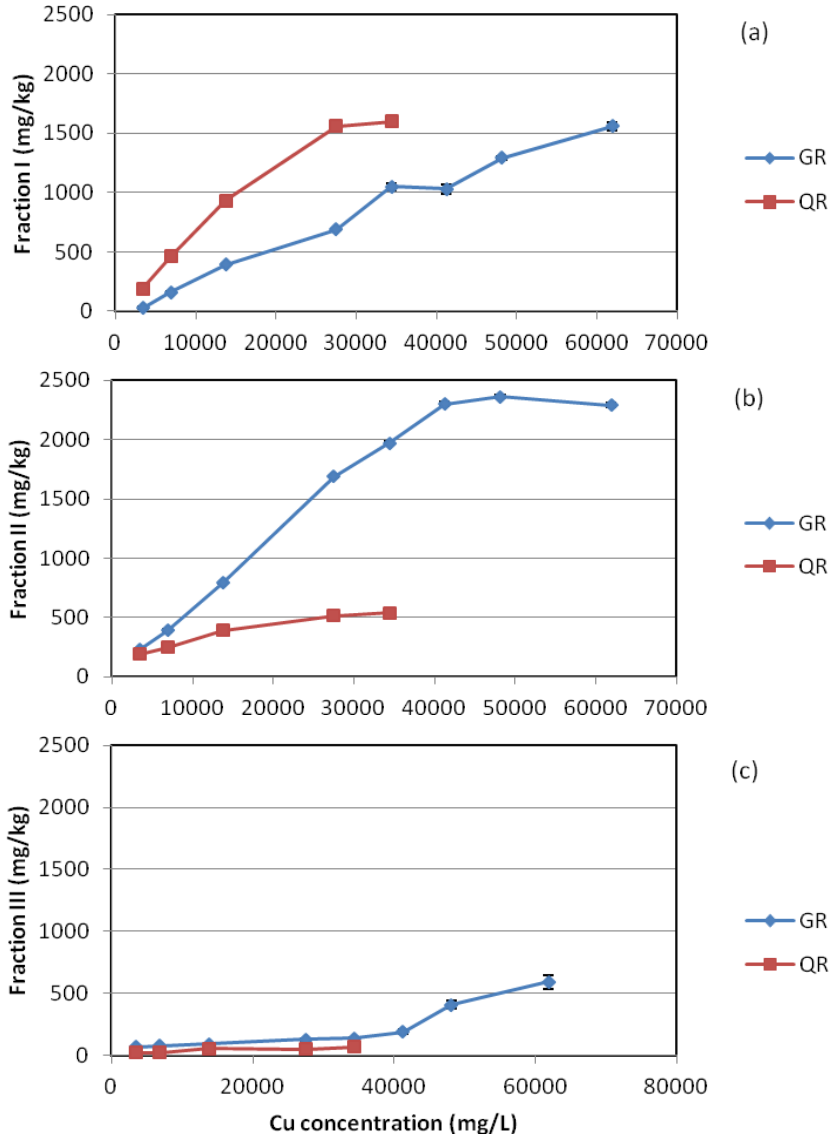
Figure 3. Comparison of the variation trend of various Cu fractions between GR and QR: ( a ) Fraction I; ( b ) Fraction II; ( c ) Fraction